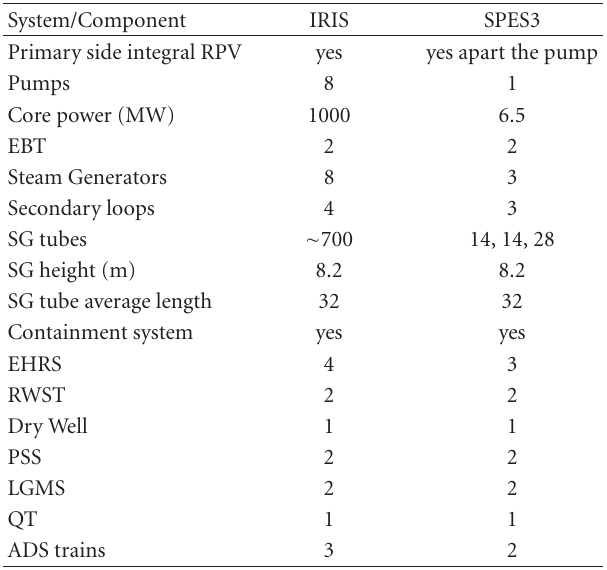
Table 1: IRIS and SPES3 characteristic